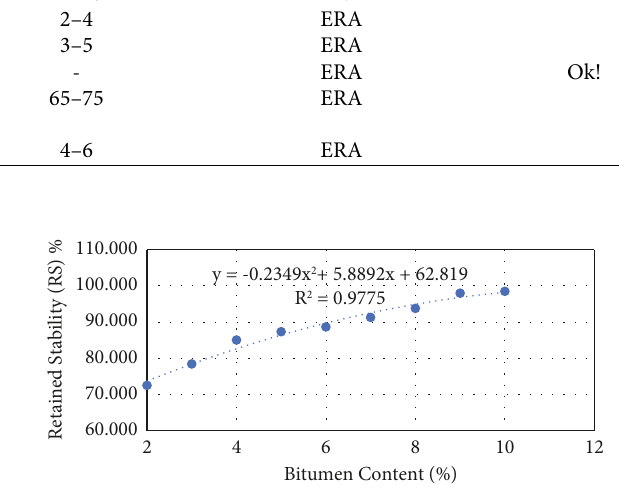
Figure 5: Retained stability (RS) of bitumen content (BC).